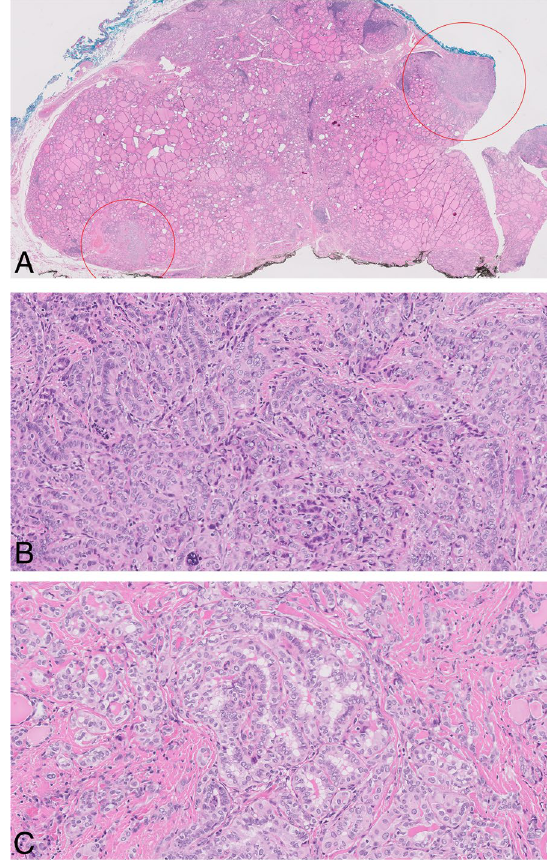
Fig. 2 Primary Thyroid Carcinoma. A Low power view (0.5x) of H&E section from left thyroid lobe shows two foci of papillary thyroid carcinoma (PTC) present in a background of Hashimoto’s thyroiditis. Focus #1 is indicated by a rectangle and focus #2 is indicated by a circle. B High power view (20x) of PTC focus #1. C High power view (20x) of PTC focus #2. The neoplastic cells demonstrate characteristic PTC nuclear features (nuclear enlargement, elongation, overlapping, chromatin clearing, irregular nuclear contour, nuclear grooves and nuclear pseudoinclusions). Focus #1 also shows tall cell features with tall cell component estimated